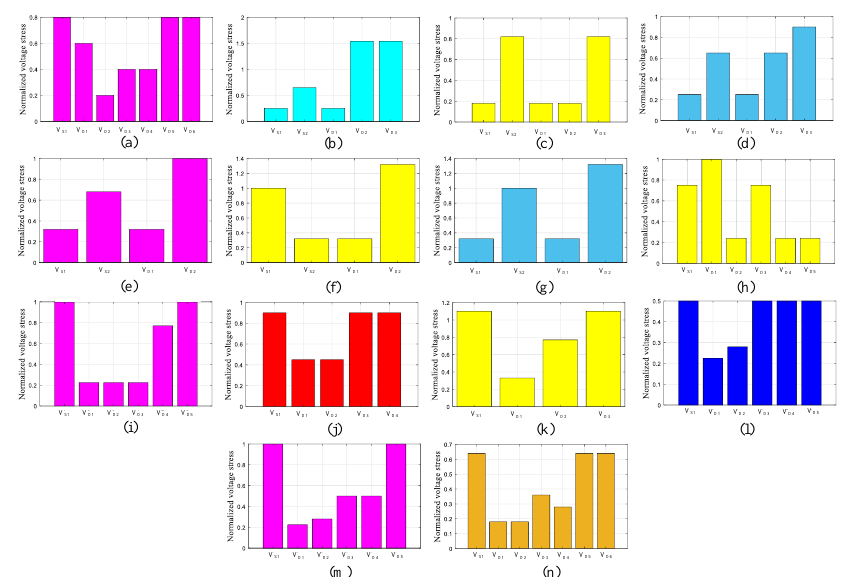
Figure 12. The comparison of the voltage stresses of the semiconductors and duty cycle among the proposed converter and recently suggested topologies for a duty cycle that provides a 10-times voltage gain: ( a ) proposed converter, ( b ) introduced topology in [18], ( c ) introduced topology in [19], ( d ) introduced topology in [20], ( e ) introduced topology in [21], ( f ) introduced topology in [22], ( g ) introduced topology in [23], ( h ) introduced topology in [24], ( i ) introduced topology in [25], ( j ) introduced topology in [26], ( k ) introduced topology in [27], ( l ) introduced topology in [28], ( m ) introduced topology in [29], ( n ) introduced topology in